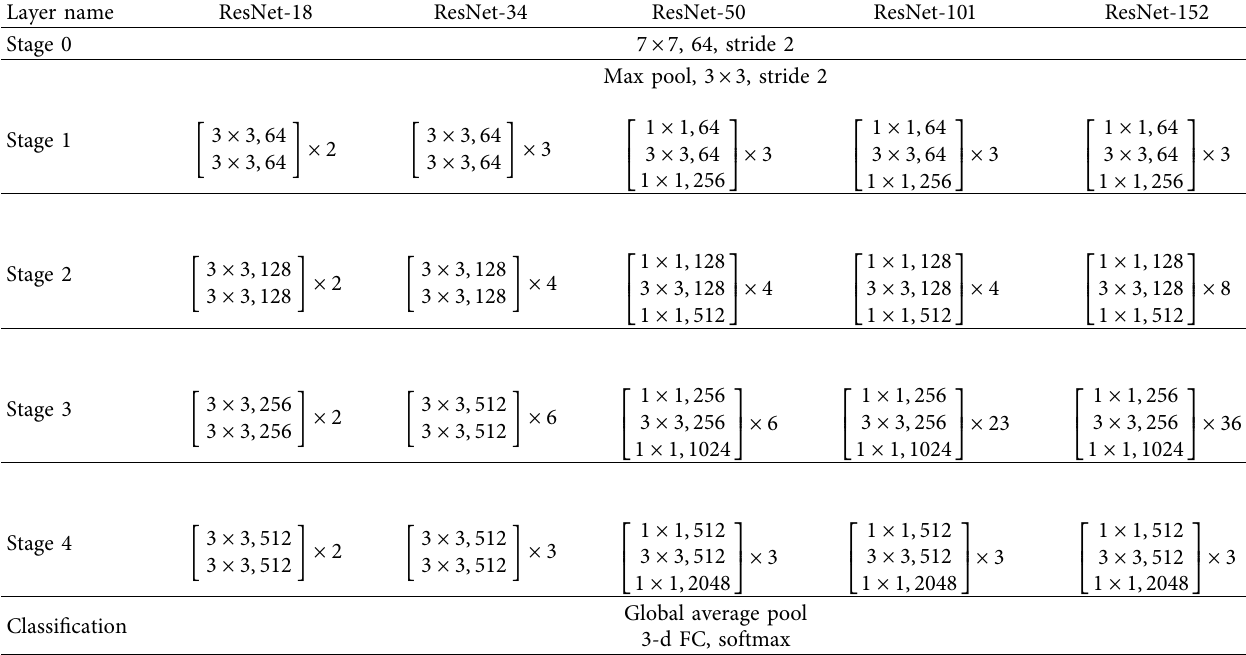
Table 3: Architectures of ResNets. Downsampling is performed by the first conv layer in each stage, with a stride of 2. Layer name